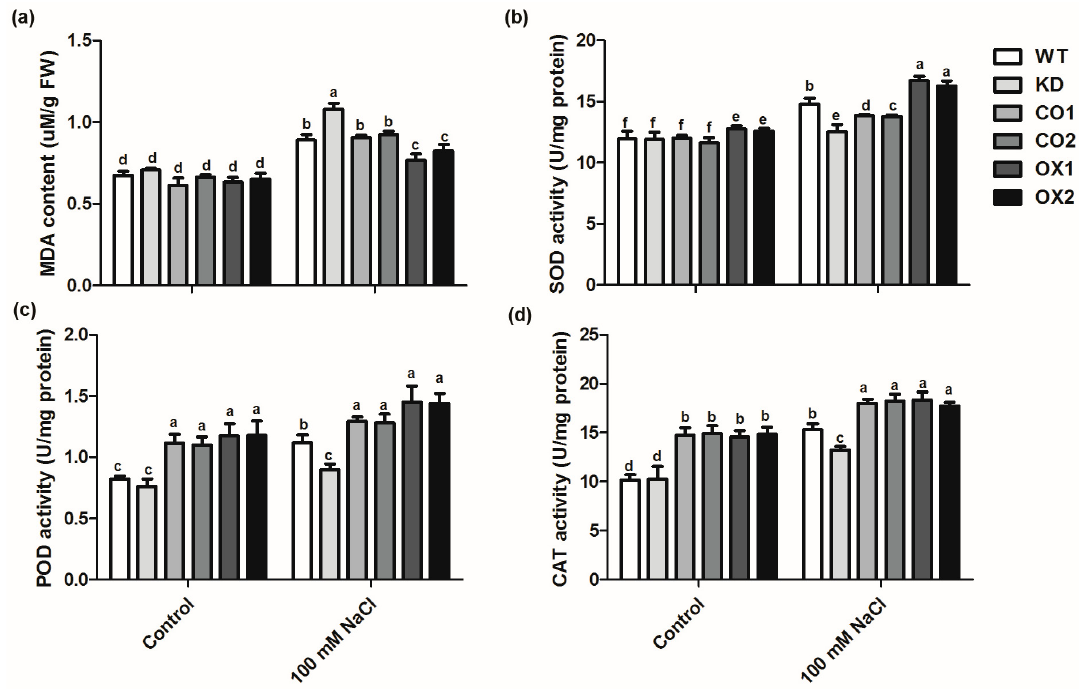
Figure 4. Effects of salt stress on antioxidant enzyme system in the leaves of wild type (WT), BvM14-SAMDC -overexpression in WT Arabidopsis (OX), atsamdc1 mutant (KD) and transgenic BvM14-SAMDC in the mutant seedlings (CO). ( a ) leaf malondialdehyde (MDA) content; (b, c and d) antioxidant enzyme activities under control and salt stress (100 mM NaCl) conditions. One unit of CAT activity was defined as the amount of enzyme required for l μ mol of H 2 O 2 decomposed within 1 min. One unit of SOD activity was defined as the amount of enzyme required for inhibition of photochemical reduction of r-nitro blue tetrazolium chloride (NBT) by 50%. One unit of POD activity was defined as the amount of enzyme required for oxidation of 5 μ mol of guaiacol within 1 min. Different letters indicate significantly different at P < 0.05. Three biological replicates were performed.